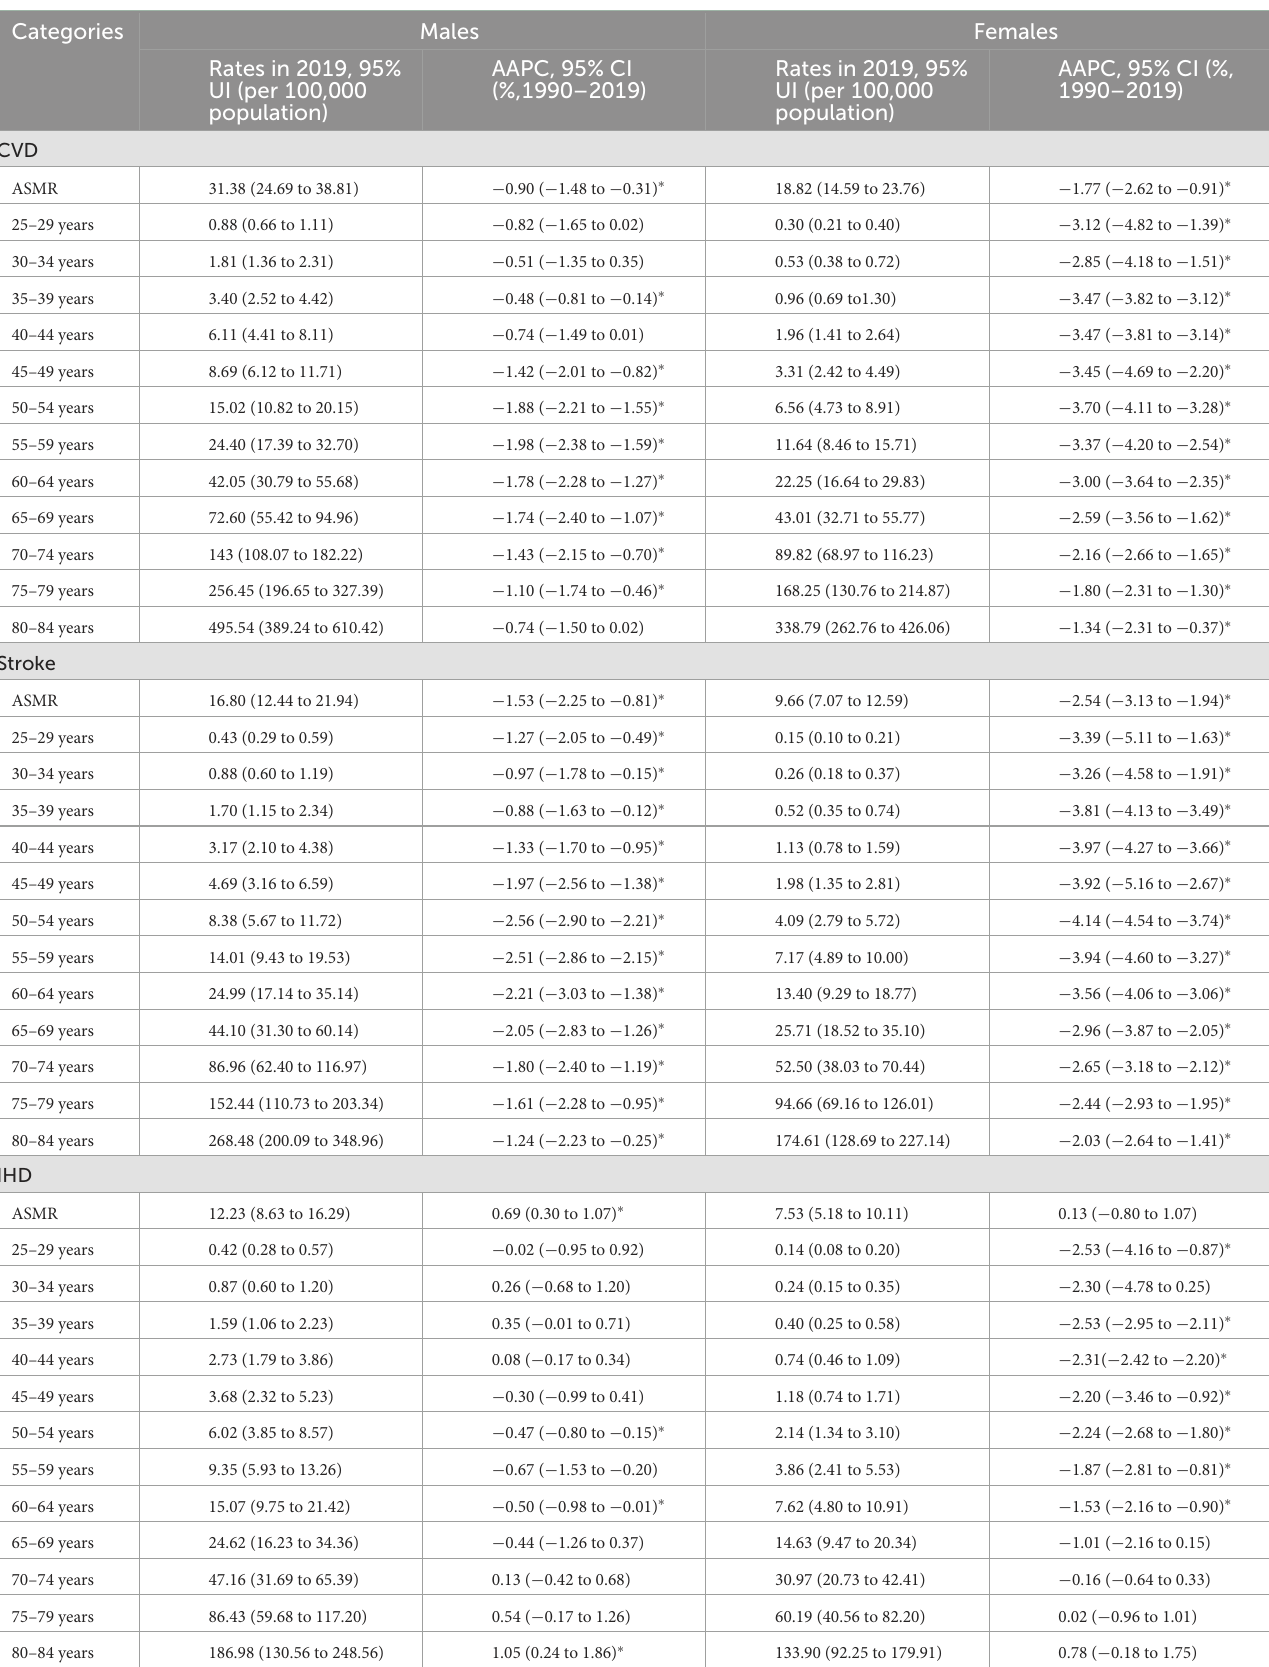
TABLE 1 Sex- and age-specific mortality rates of CVD, stroke, and IHD attributable to non-optimal temperature in China in 1990 and 2019 and their average annual percentage changes (AAPC) from 1990 to